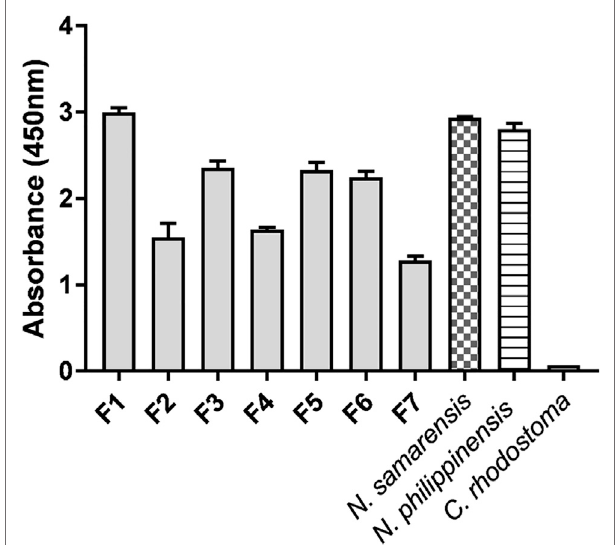
FIGURE 5 | Immunoreactivity of Philippine Cobra Antivenom (PCAV) toward the reverse-phase high-performance liquid chromatography (RP- HPLC) protein fractions (F1-F7) of Naja samarensis venom. Values were means ± S.E.M. of triplicates. Naja philippinensis and Calloselasma rhodostoma venoms were used as positive and negative controls,